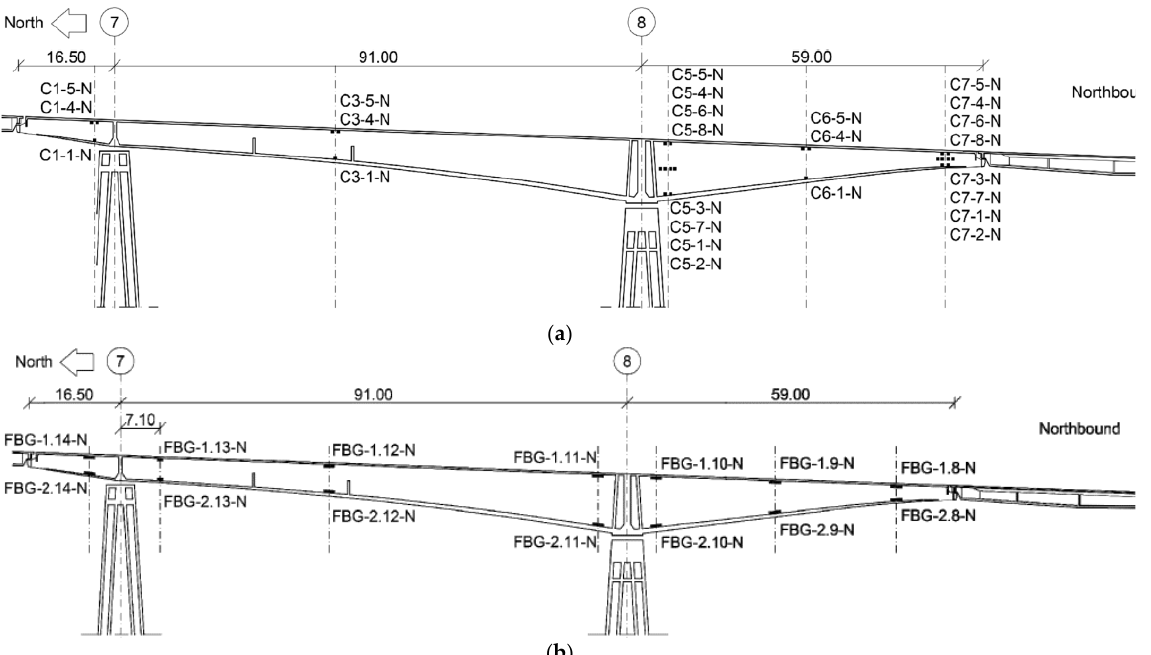
Figure 6. Positions of ( a ) the RTDs and ( b ) the FOSs on the northernmost cantilever of the north- bound carriageway. The dimensions are given in meters. carriageway. The dimensions are given in